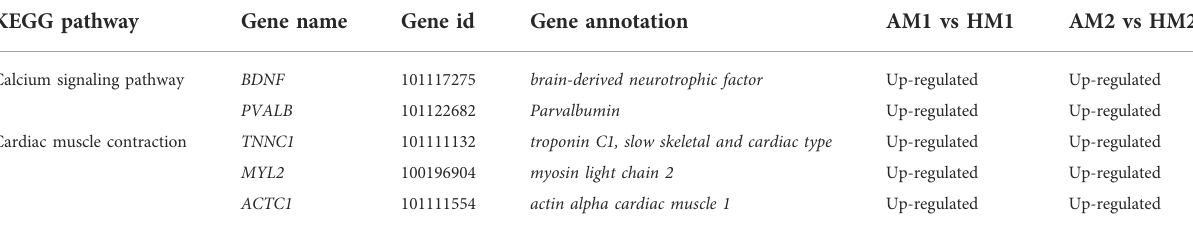
TABLE 4 The up-regulated differentially expressed genes (DEGs) related to energy homeostasis in Altay compared to Hu lambs. KEGG